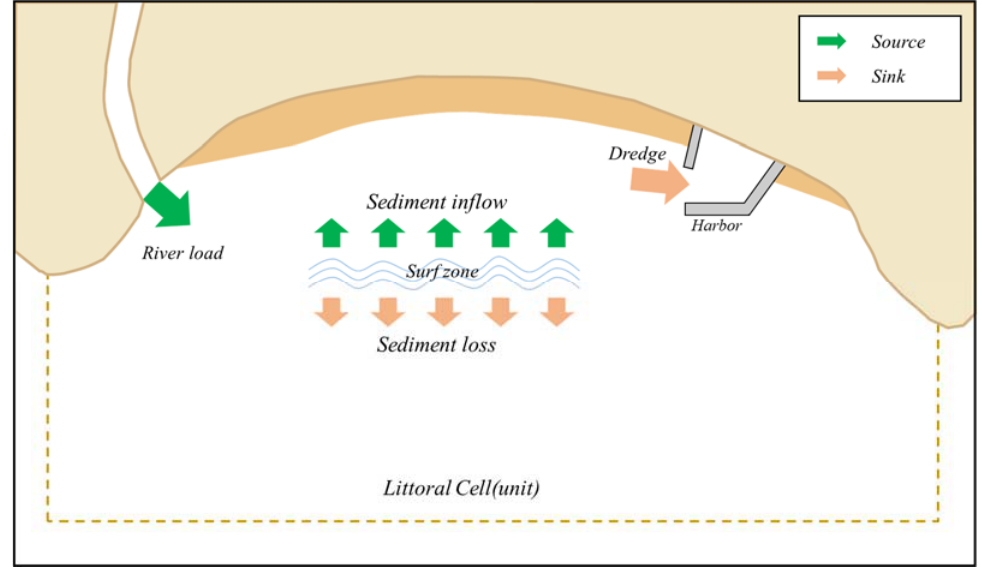
Figure 4. Sediment budget system in littoral cell.